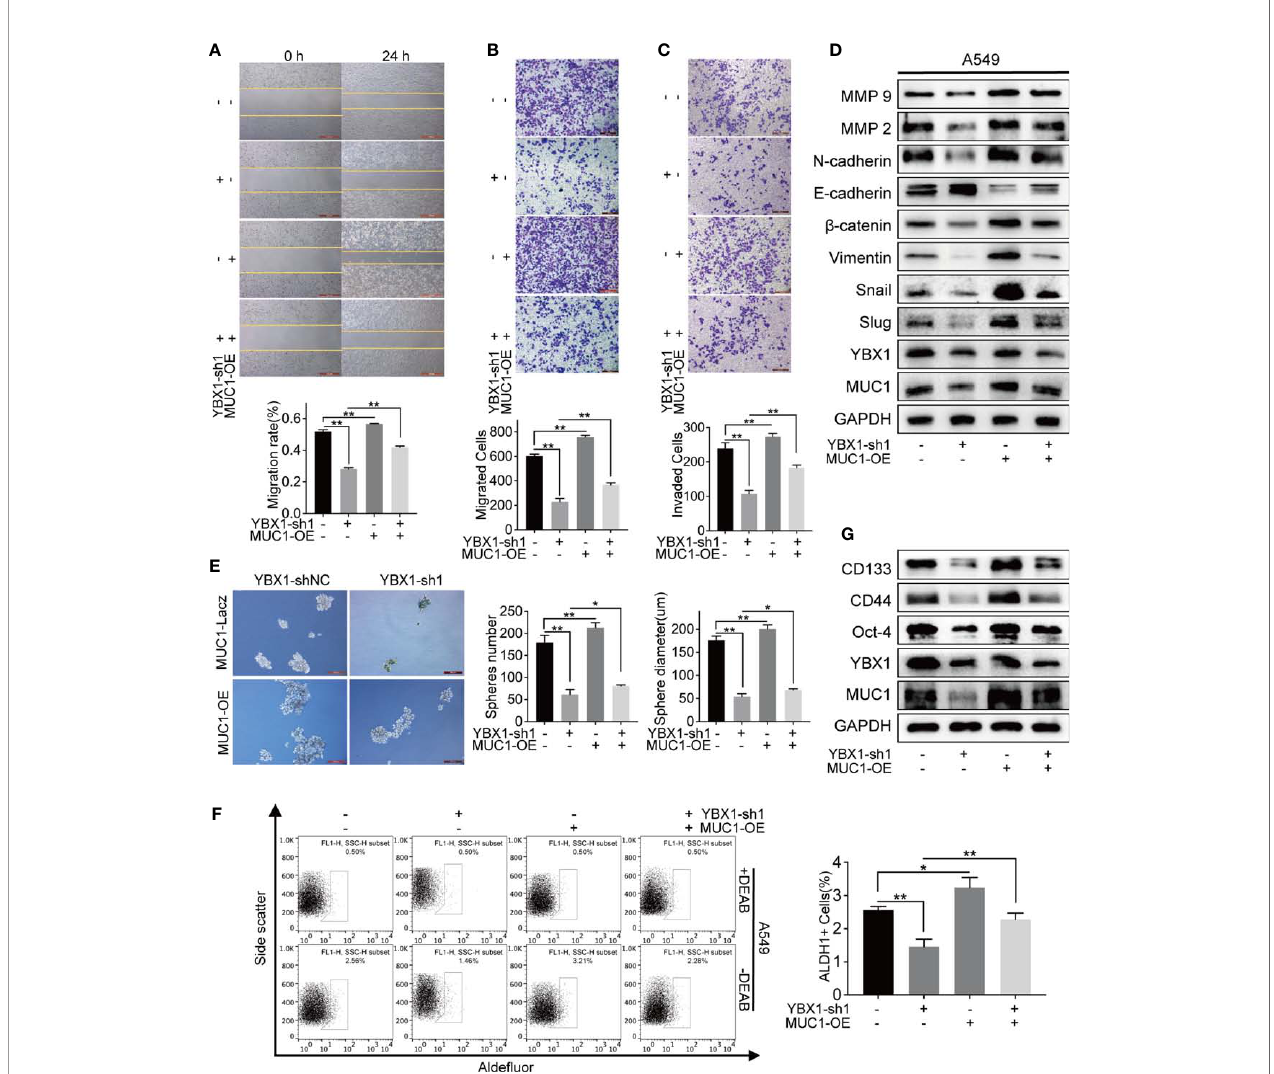
FIGURE 4 | MUC1 overexpression partly rescued the down-regulation of metastasis and stemness caused by YBX1 silencing. (A) Cell migration was analyzed by wound healing assay in A549, and the migration rate was partly rescued by MUC1 overexpression. (B) Cell migration was analyzed by transwell assay without matrigel, and the migrated cells were partly rescued by MUC1 overexpression. (C) Cell invasion was analyzed by transwell assay with matrigel, and the invaded cells were partly rescued by MUC1 overexpression. (D) MUC1 overexpression partly rescued the regulation of the EMT signaling and MMPs family caused by YBX1 silencing. (E) Cancer cell stemness was analyzed by sphere formation in A549. The number and diameter of the spheres were partly rescued by MUC1 overexpression. (F) ALDH1 positive population analysis revealed that MUC1 overexpression increased the number of ALDH1+ cells reduced by YBX1 silencing. (G) MUC1 overexpression partly rescued the regulation of the markers related to stemness, including CD44, CD133, Oct-4, caused by YBX1 silencing. The data are presented as mean ± SD of three independent tests. *P < 0.05, **P <